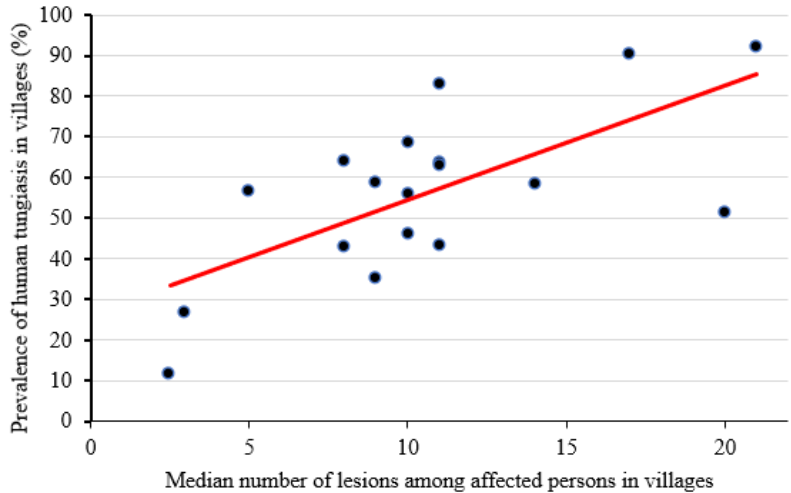
Figure 6. The prevalence of human tungiasis in villages and the median number of lesions were positively correlated at the village level (rho = 0.58, p = 0.01).